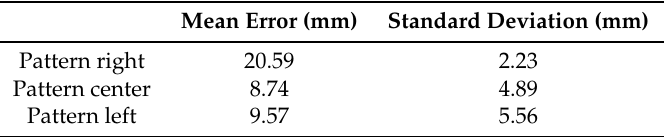
Table 4. Reconstruction error in